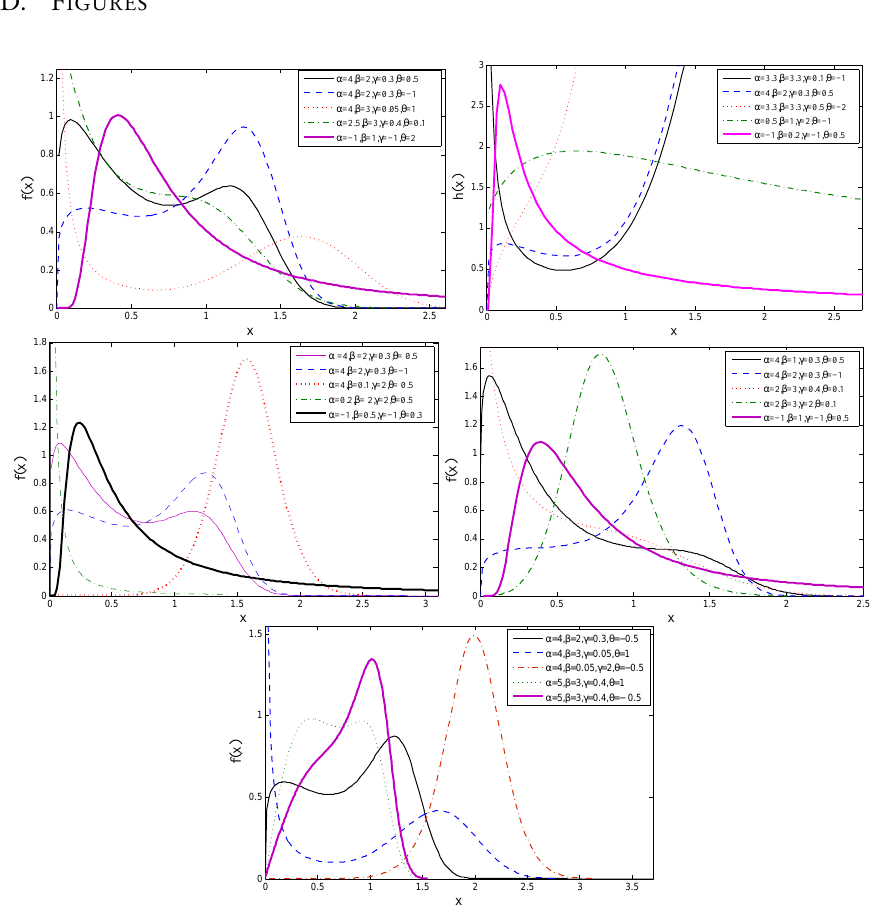
Figure 1 – Plots of the OWPS pdf for some parameter values: odd Weibull Poisson (top left), odd Weibull geometric (top right), odd Weibull logarithmic (middle left), odd Weibull negative binomial (middle right) and odd Weibull binomial (bottom)